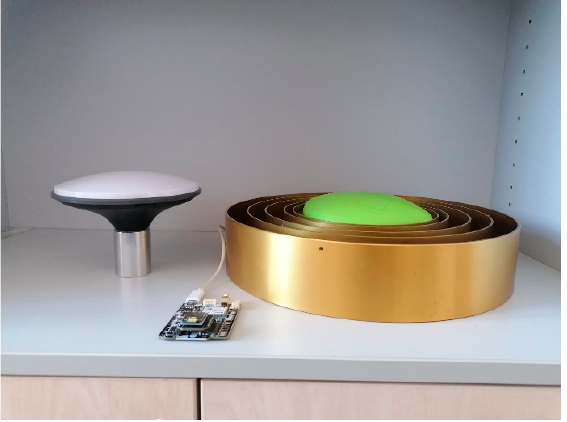
Figure 1. Low-cost GNSS receiver simpleRTK2B V1 (in front), Survey calibrated low-cost antenna (left), and Javad RingAnt-G3T geodetic antenna (right).